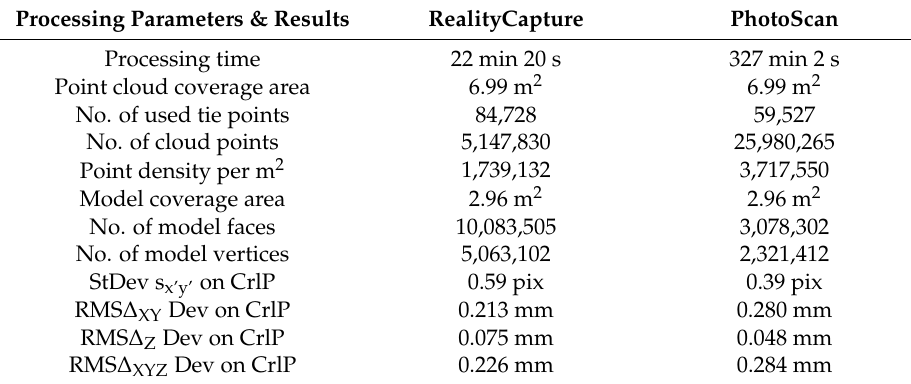
Table 1. Parameters and results of images processing.